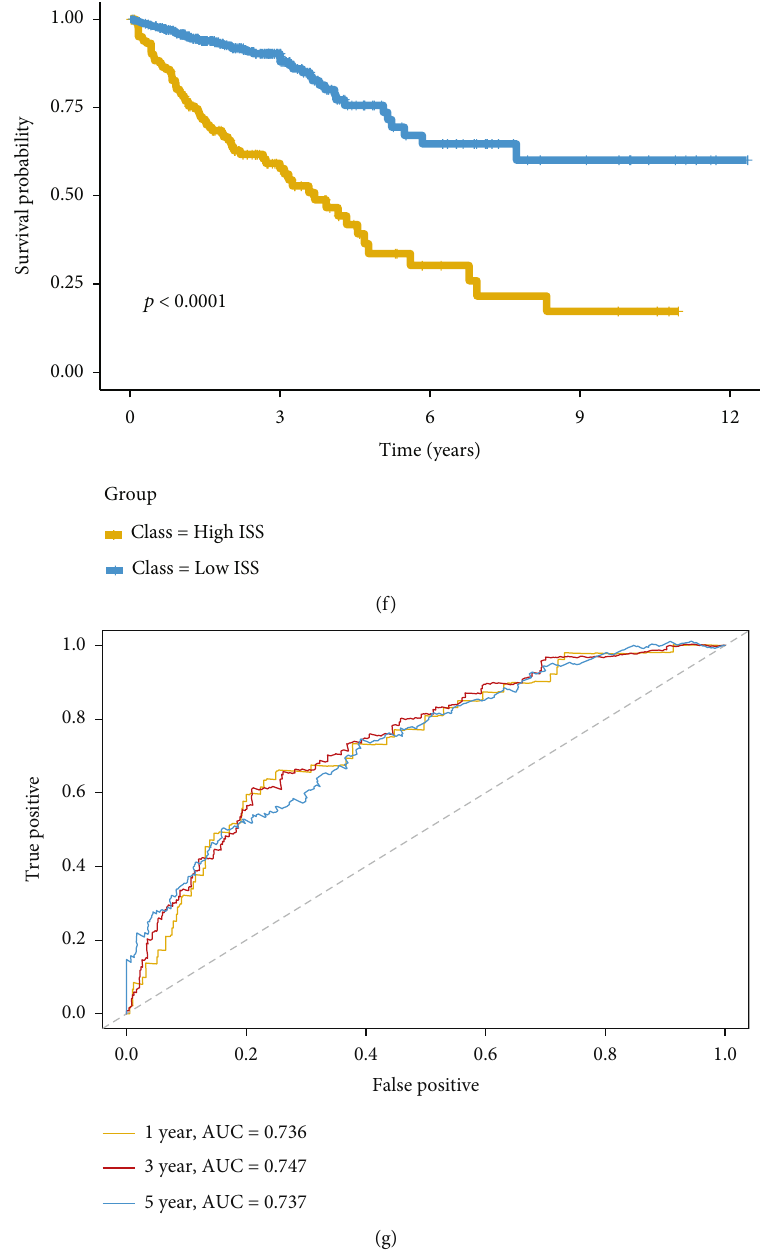
Figure 4: Construction of the immune feature-based prognostic model: (a) volcano plot representing the DEGs between the immune suppressive and immune active CRC subtypes; (b, c) LASSO regression was employed to construct the model; (d) coe ffi cients of the selected genes; (e) distribution of the high- and low-ISS groups in the training cohort; (f) comparison of patient prognosis between the high- and low-ISS groups in the training cohort; (g) ROC curve for ISS in the training